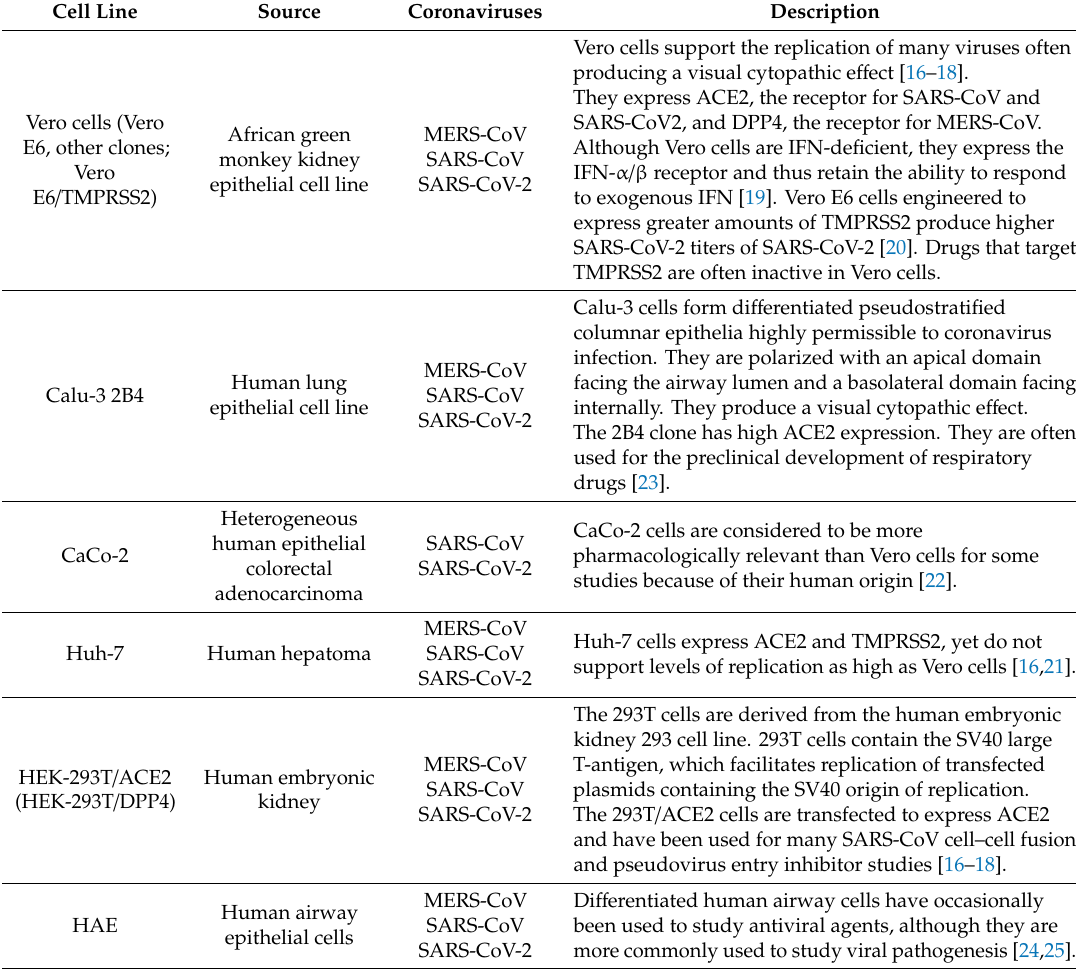
Table 1. Frequently used cells for culturing pandemic coronavirus antiviral